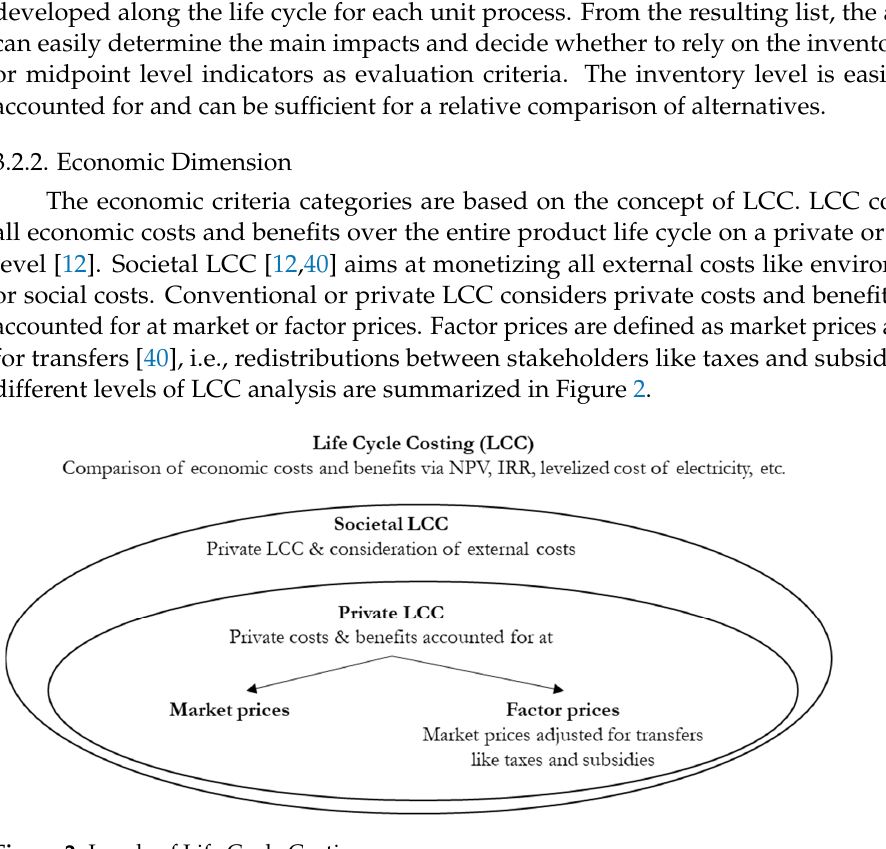
Figure 2. Levels of Life Cycle